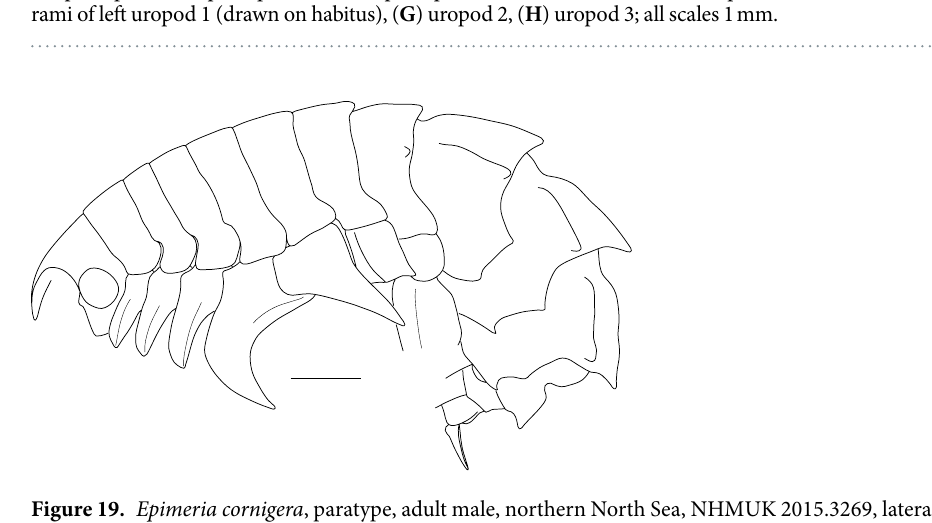
Pereopod 6 (Fig. 18C) coxa subrectangular, longer than wide with a laterally protruding ridge anteriorly and an angular lateral lobe pointing posterodistally, anterior margin with fine setae; basis slightly curved posteriorly, with lobe roundly expanding proximally on the medial side of the posterior margin and posteriorly produced lateral margin which expands to a bifid subrectangular lobe distally, posteromedial lobe with many slender setae mediodistomarginally, anterior margin with long slender setae proximally and few setae along the distal half; ischium longer than wide, lobate; merus about 1.3 the length of carpus, slightly curved anteriorly and slightly expanding distally, with very short setae along the posterior margin and tufts of setae postero- and anterodistally;